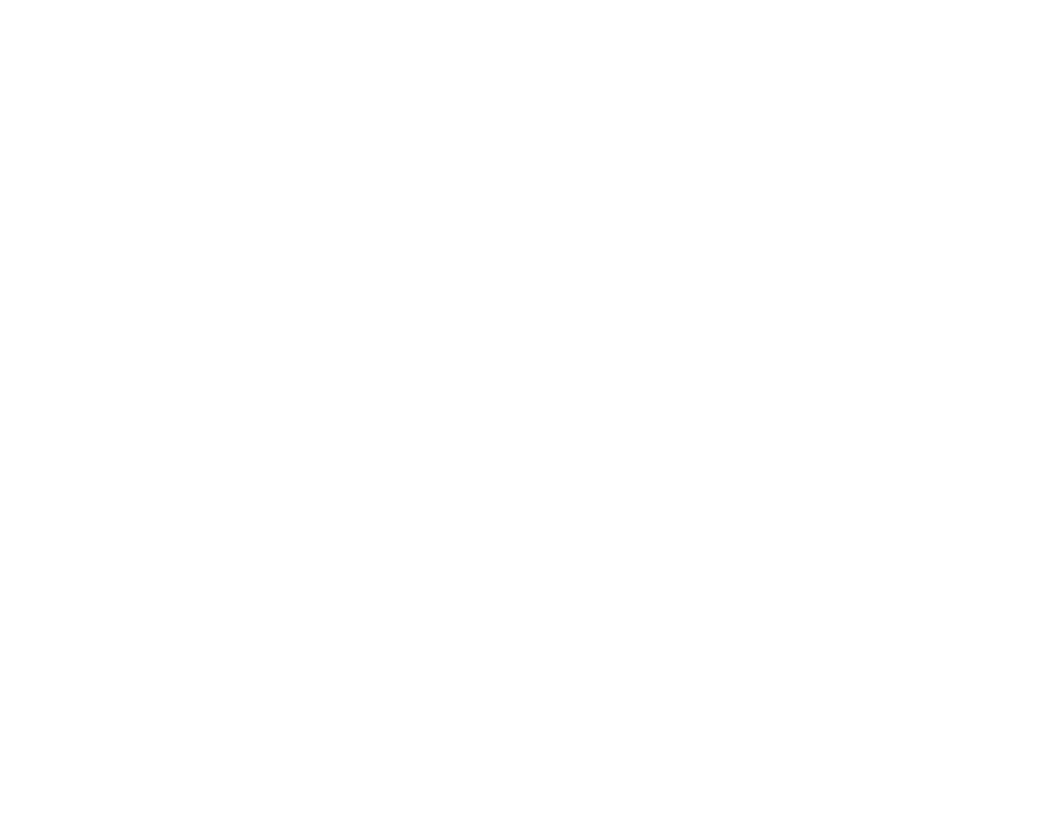
Fig 8. Egg density of D . kuriphilus ( v releases of T . sinensis made simultaneously, at years 1 and n r according to a regular mesh 4 × 4.